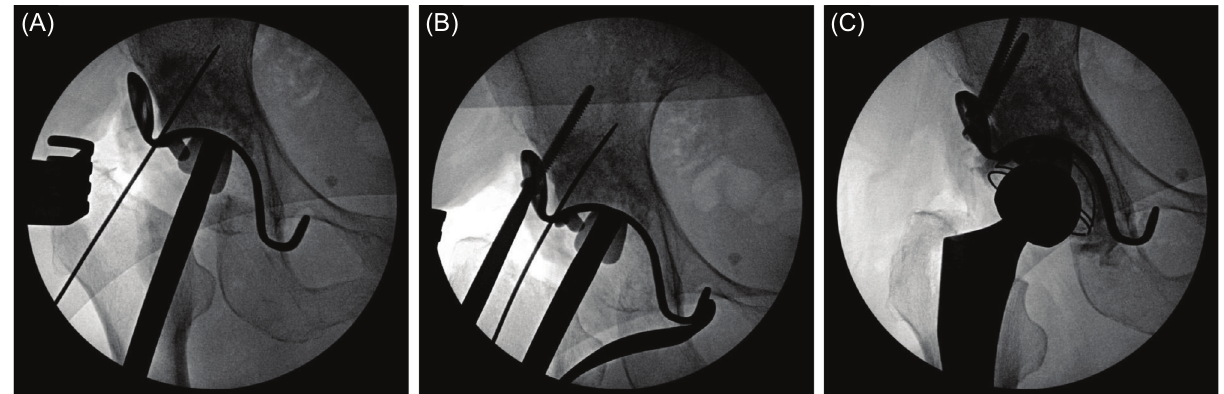
Figure 5. (A, B) After confirming that the KT plate was placed at an appropriate position, the retractor was set on the hook, and the plate was firmly pressed and attached to the tear drop. (C) A polyethylene liner with an optimum size was fixed with